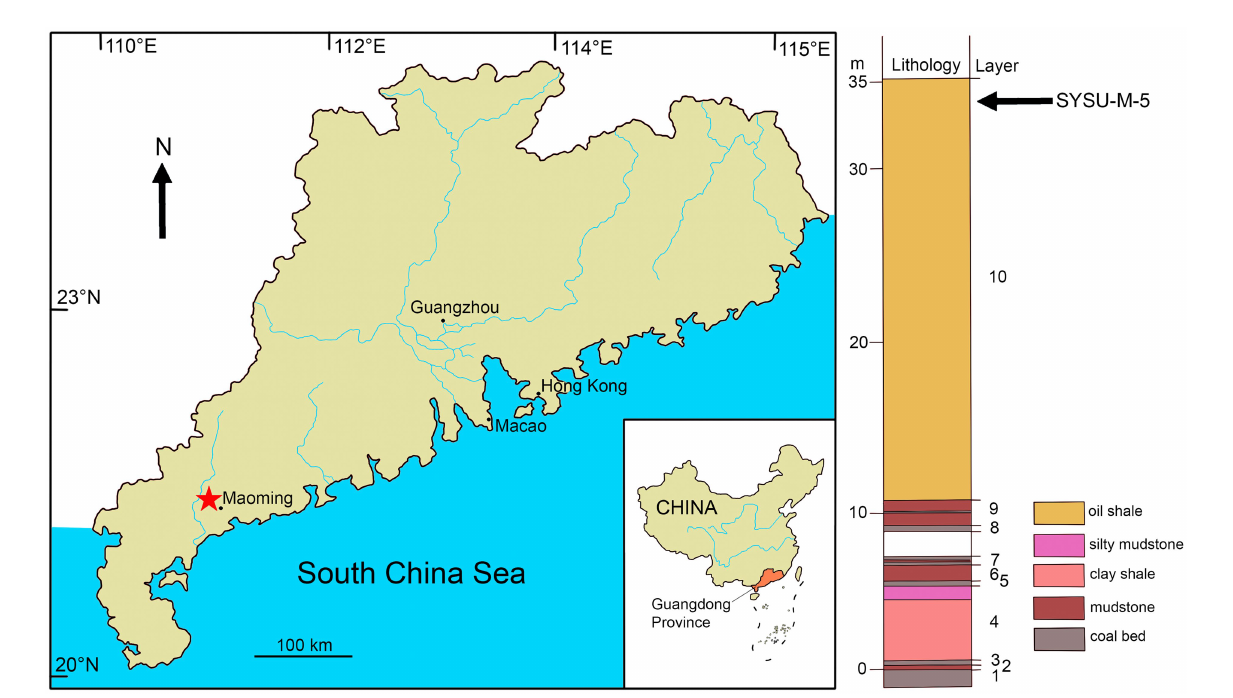
FIGURE 1 Geographic position of Maoming locality designated by star on the map of Guangdong Province, China (left) and stratigraphic position of SYSU-M-5, holotype of Maocyon peregrinus , gen. et sp. nov., indicated by arrow on the stratigraphic column of the Youganwo Formation